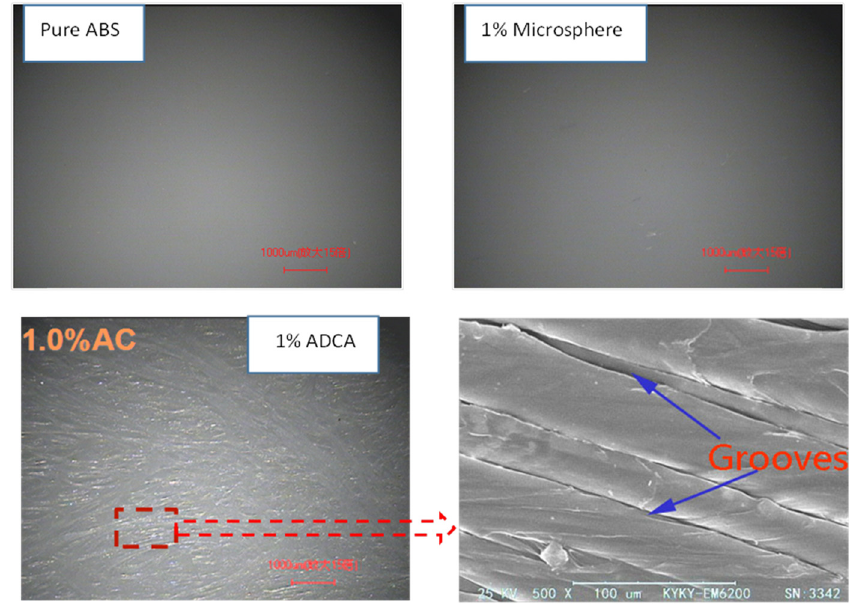
Figure 7: Surface quality of foamed ABS material under a light microscope.